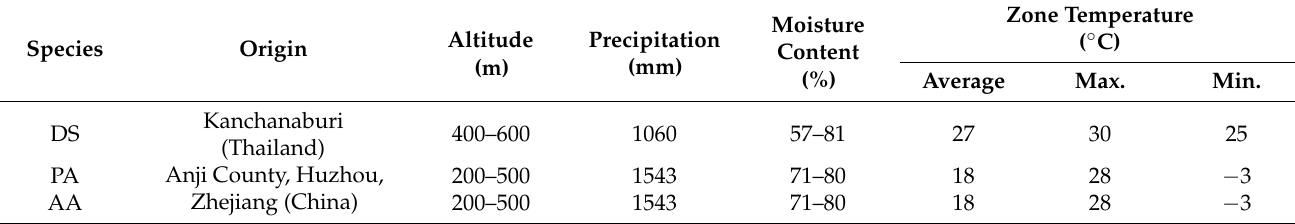
Table 1. Origin and growth conditions of the three bamboo species.